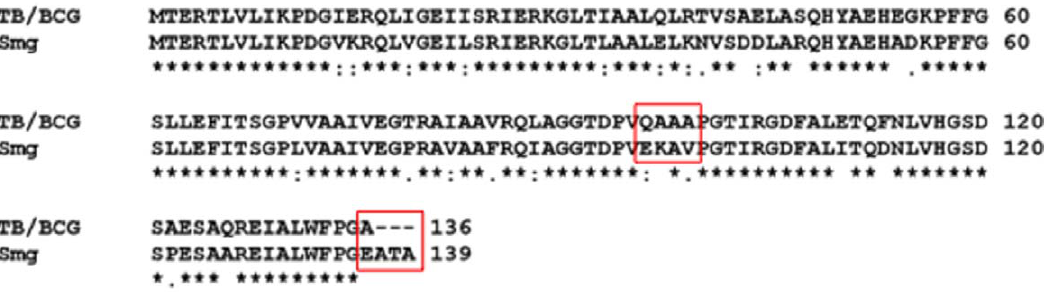
Figure 7. Sequence alignment of Mtb , BCG, and M.smegmatis . There is 100% homology between Mtb and BCG Ndk, which decreases to , 80% when compared to M. smegmatis Ndk. Residues of difference that could potentially be important in the catalytic GAP activity are highlighted.